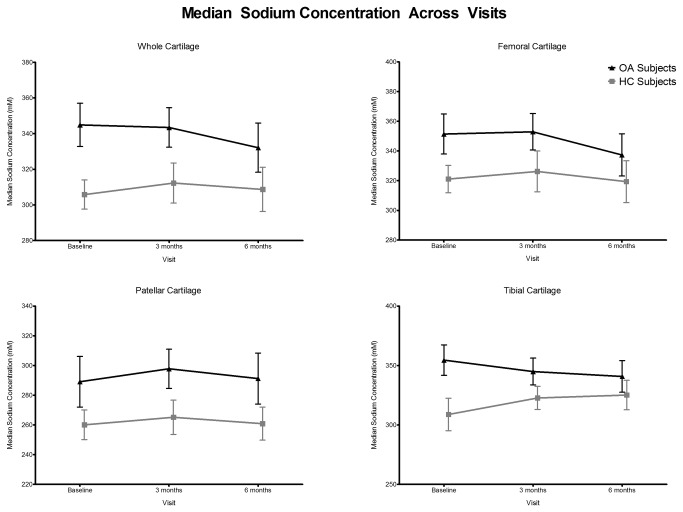
Group means in OA and HC subjects of median sodium concentration at baseline, 3 months and 6 months for whole, tibial, femoral and patellar cartilage ROIs.Whiskers denote the standard error of the mean.